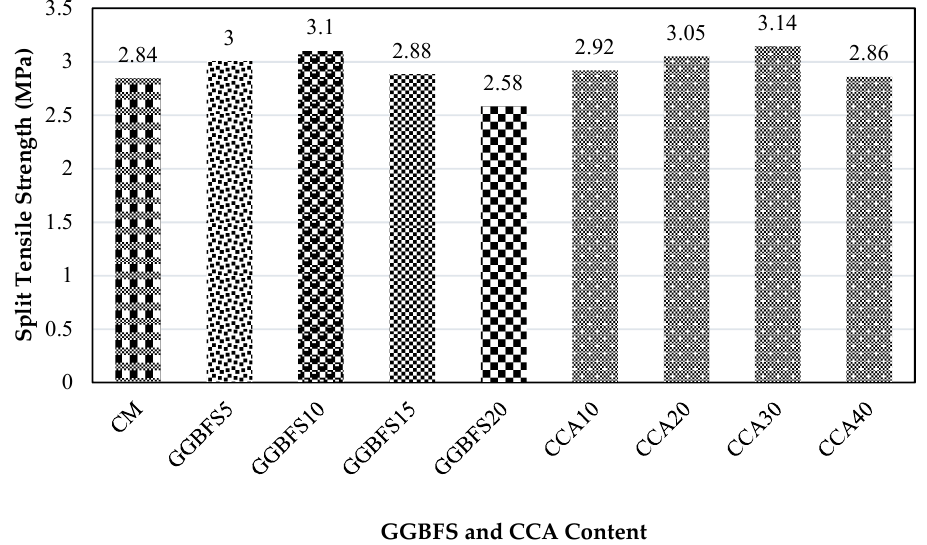
Figure 12. Splitting tensile strength of concrete containing GGBFS and CCA.